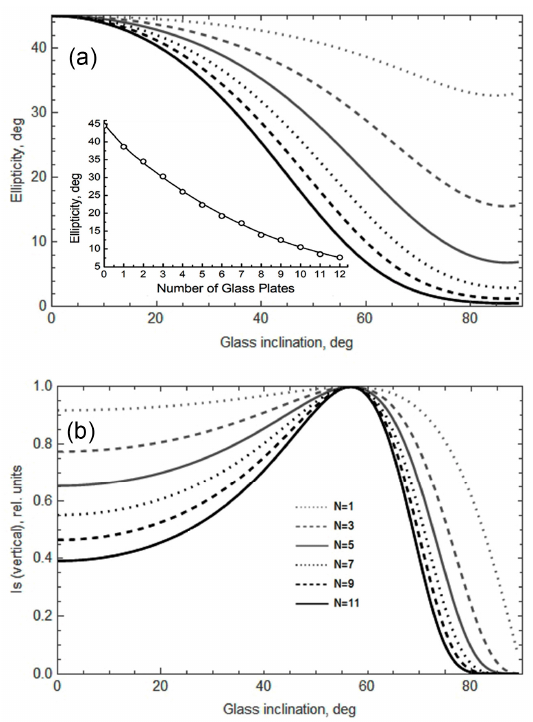
Figure A1. Characteristics of the output radiation of a regulated linear polarizer consisting of N thin glass plates-calculation by Formulas (A5)–(A9); the input light is circularly polarized. ( a ) Dependence of the ellipticity of the output light on the angle of inclination of the glass plates; Inset: ellipticity of the output light as a function of the number N of glass plates set at the Brewster angle. The line is the calculation; the circles are the experiment. ( b ) Dependence of the transmission of the s -component of radiation on the angle of inclination of the glass plates.